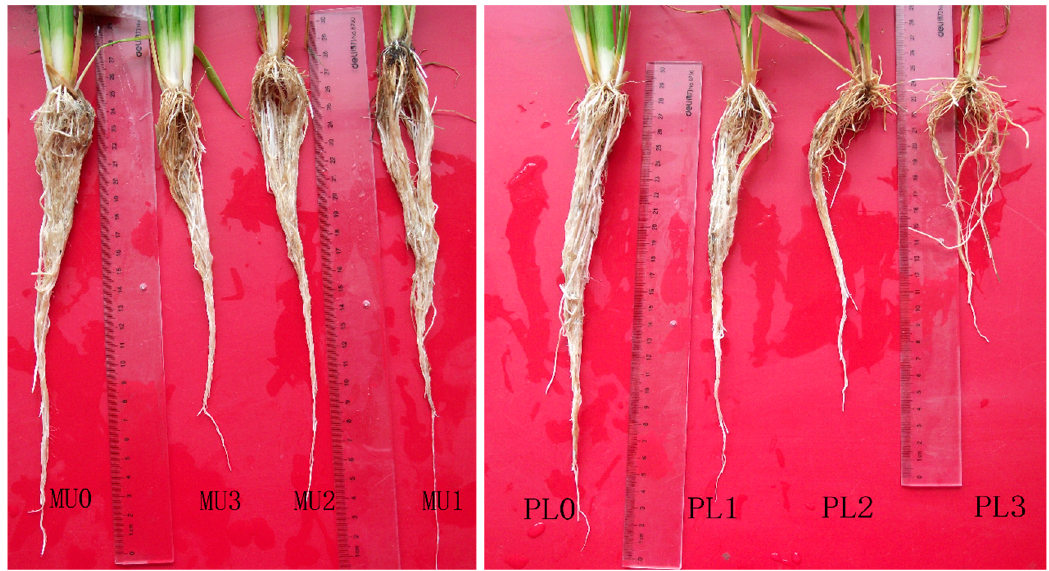
Figure 3. Comparison of root length of rice under different straw returning treatments, MU 0 , MU 1 , MU 2 , and MU 3 represent 0.0 t/hm 2 , 1.5 t/hm 2 , 3.0 t/hm 2 , and 4.5 t/hm 2 of straw, respectively, which were incorporated into the soil by a mulching method. Whereas PL 0 , PL 1 , PL 2 , and PL 3 represent 0.0 t/hm 2 , 1.5 t/hm 2 , 3.0 t/hm 2 , and 4.5 t/hm 2 of straw, respectively, which were incorporated in soil by a plowing method.